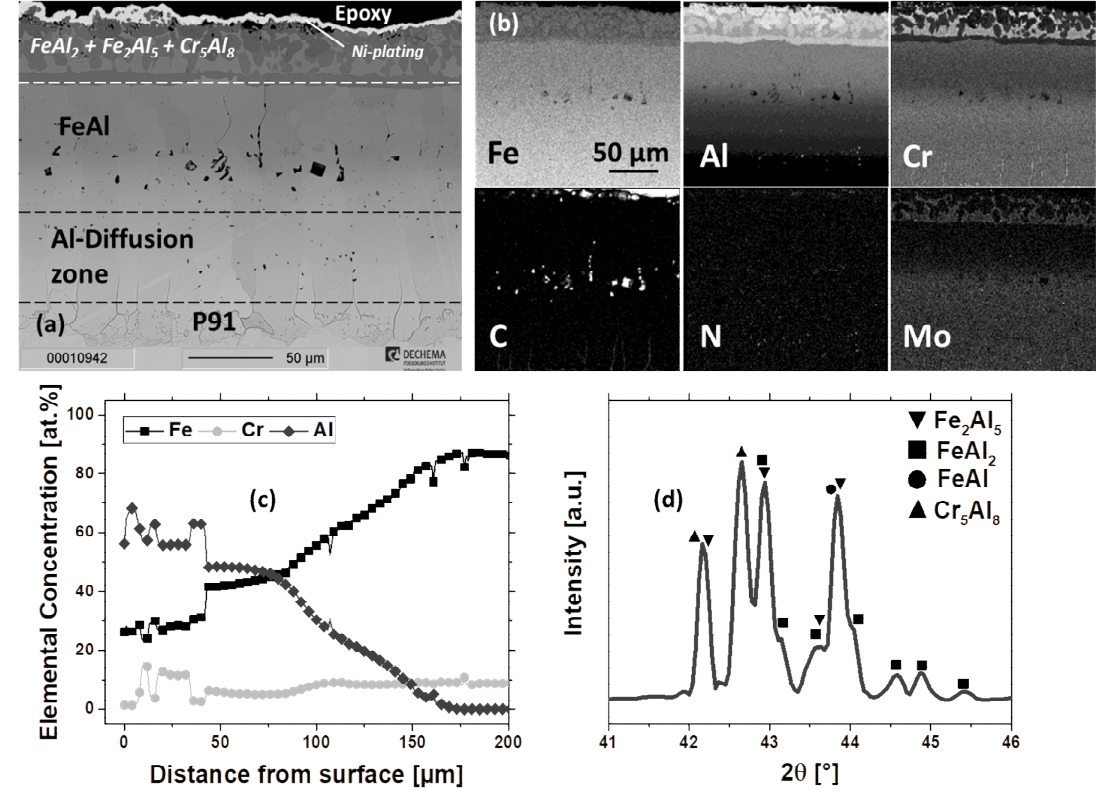
Figure 4. ( a ) Cross-sectional BSE-image, ( b ) elemental distribution maps and ( c ) quantitative line scans of Fe, Cr, and Al, as well as ( d ) XRD-pattern of Cr / Al-di ff usion coated